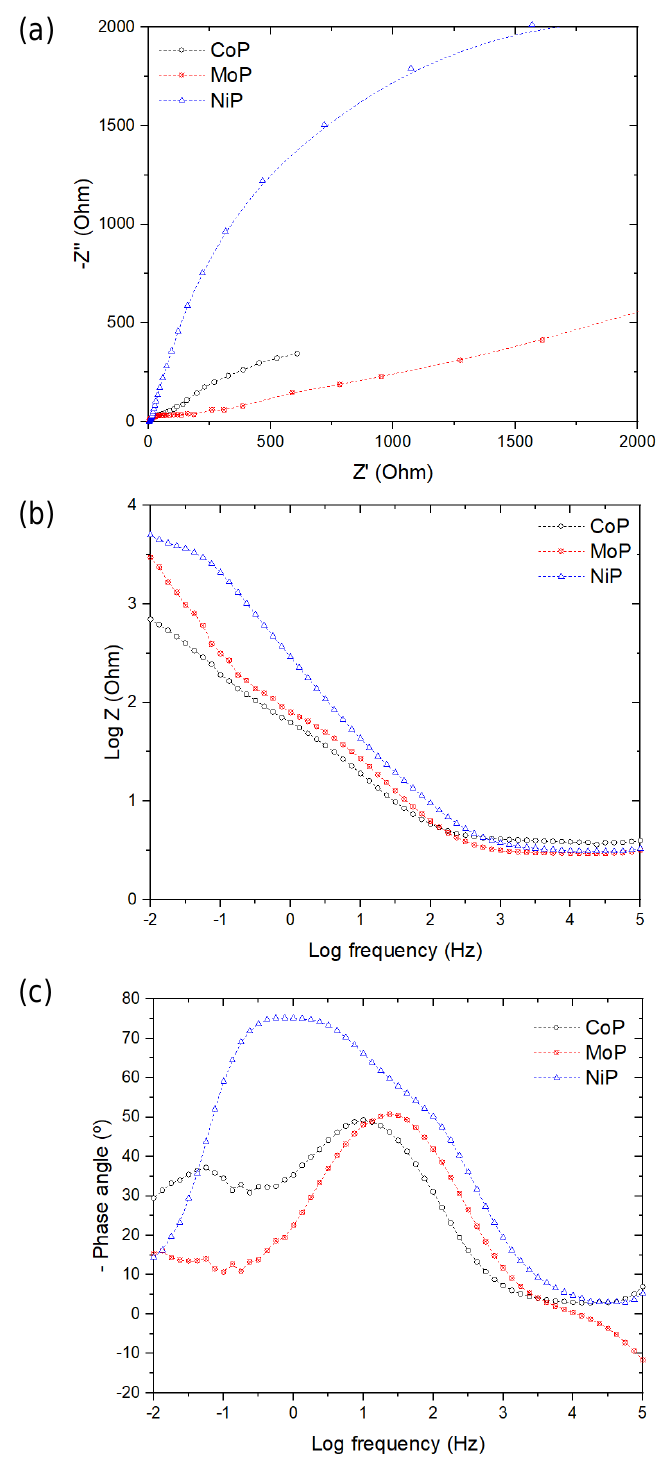
Figure 7. EIS representation for CoP, MoP, and NiP. ( a ) Nyquist, ( b ) Bode, and ( c ) phase represen- tations.